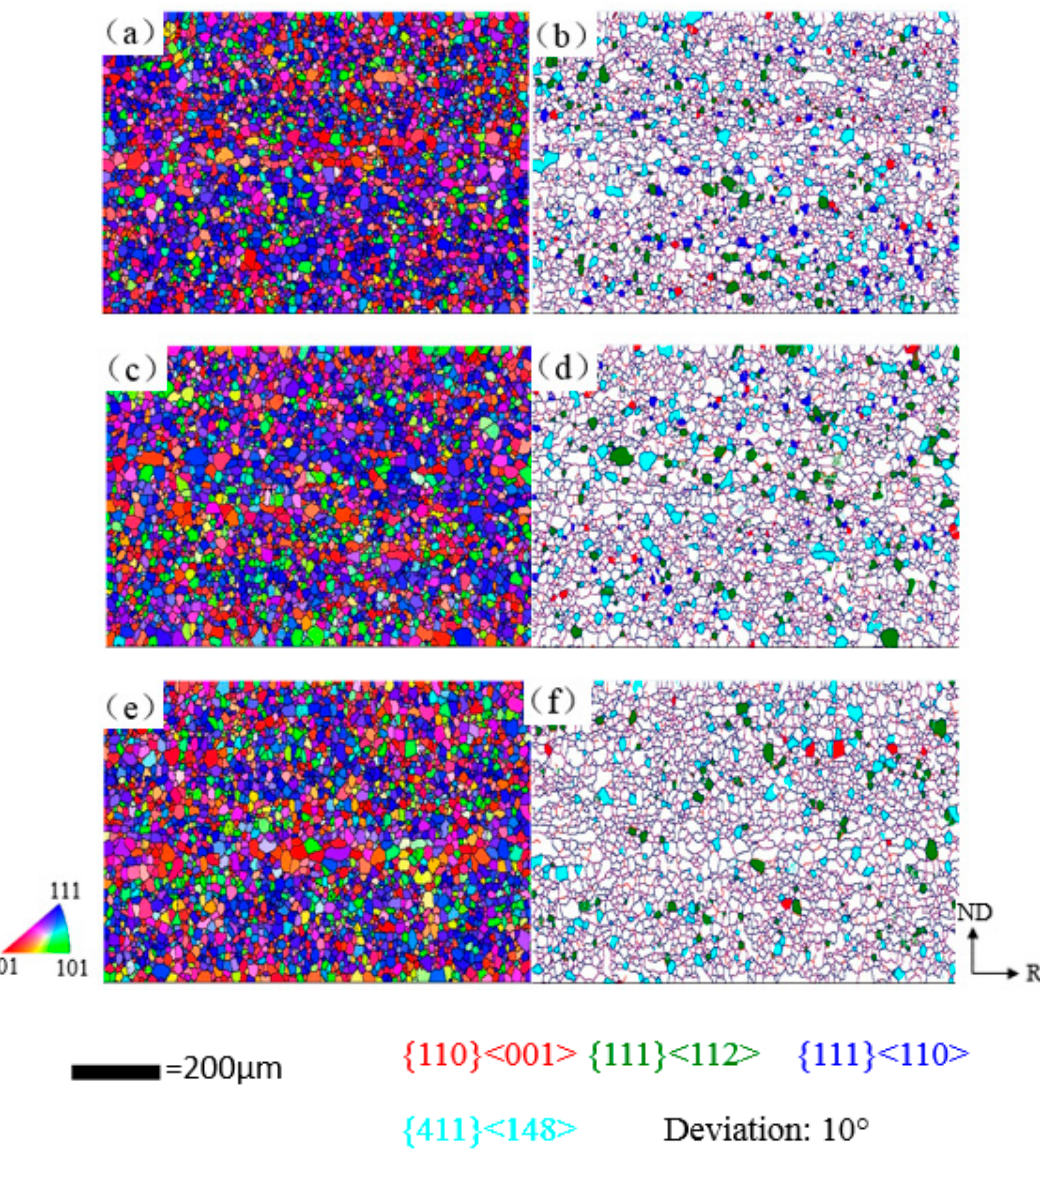
Figure 8. IPF maps and main textures distribution of decarburized specimens normalizing. At 920 °C ( a , b ), 950 °C ( c , d ), 980 °C ( e , f ).